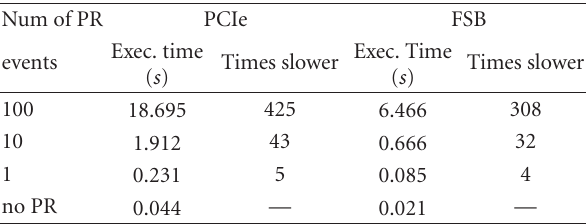
Table 1: PR overhead at di ff erent PR event granularities.